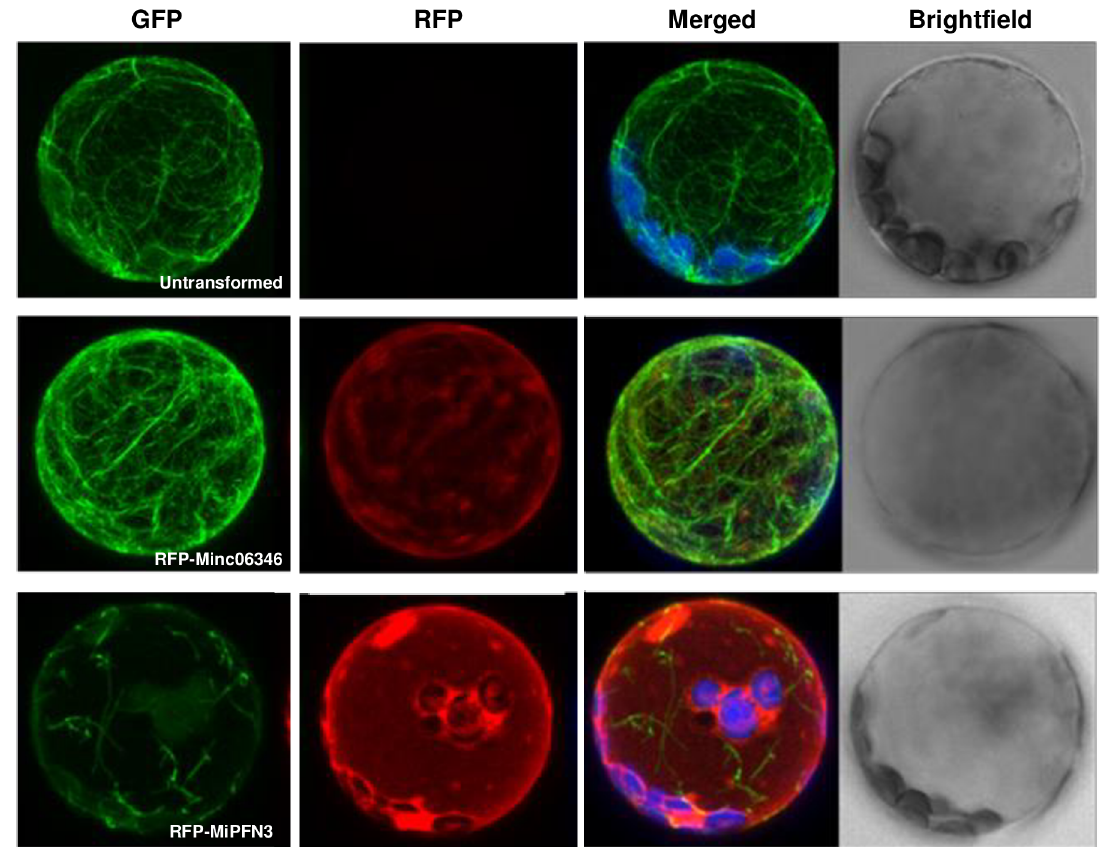
Fig 8. MiPFN3 disrupts the actin cytoskeleton in protoplasts. ABD2-GFP Arabidopsis protoplasts were transfected with RFP:Mi06346 or RFP:MiPFN3 and imaged by confocal microscopy (40x magnification). In the presence of MiPFN3, protoplasts showed altered actin filament structure. These experiments were performed at with at least 30 of ABD2-GFP protoplasts from each transfection and experiment was repeated at least twice times with similar results.